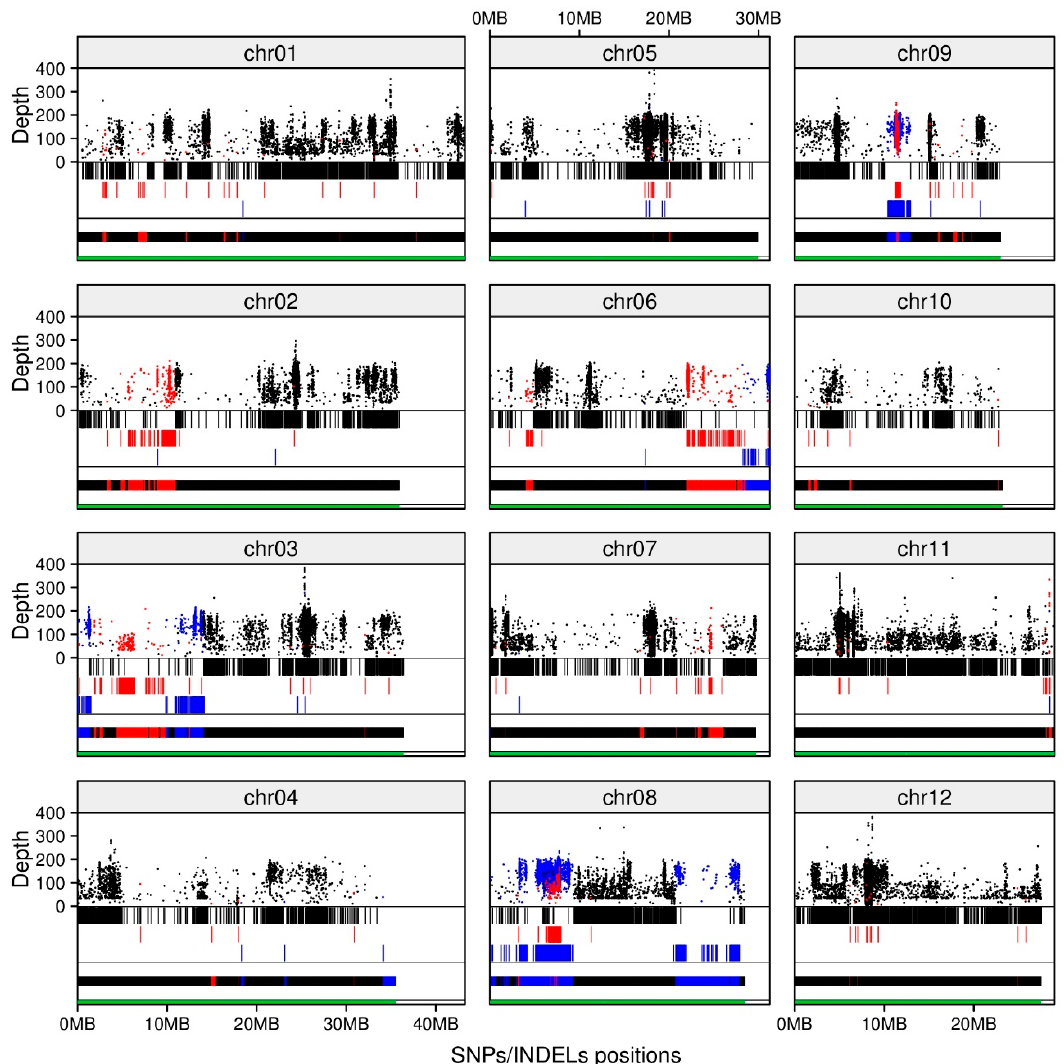
Figure 2. Positions and depths of SNPs/indels and genotype blocks on BC 3 F 2 #31-2-4 genome . Dots show coverage depth of SNPs/indels. Vertical bars show their positions by genotype (color). Horizontal bar shows densities of SNPs/indels densities in 10,000-nt sliding window by genotype (colour). Black, “Yukinko-mai”-type homozygous; red, “Kaijin”-type homozygous; blue, heterozygous. Green bars represent chromosome